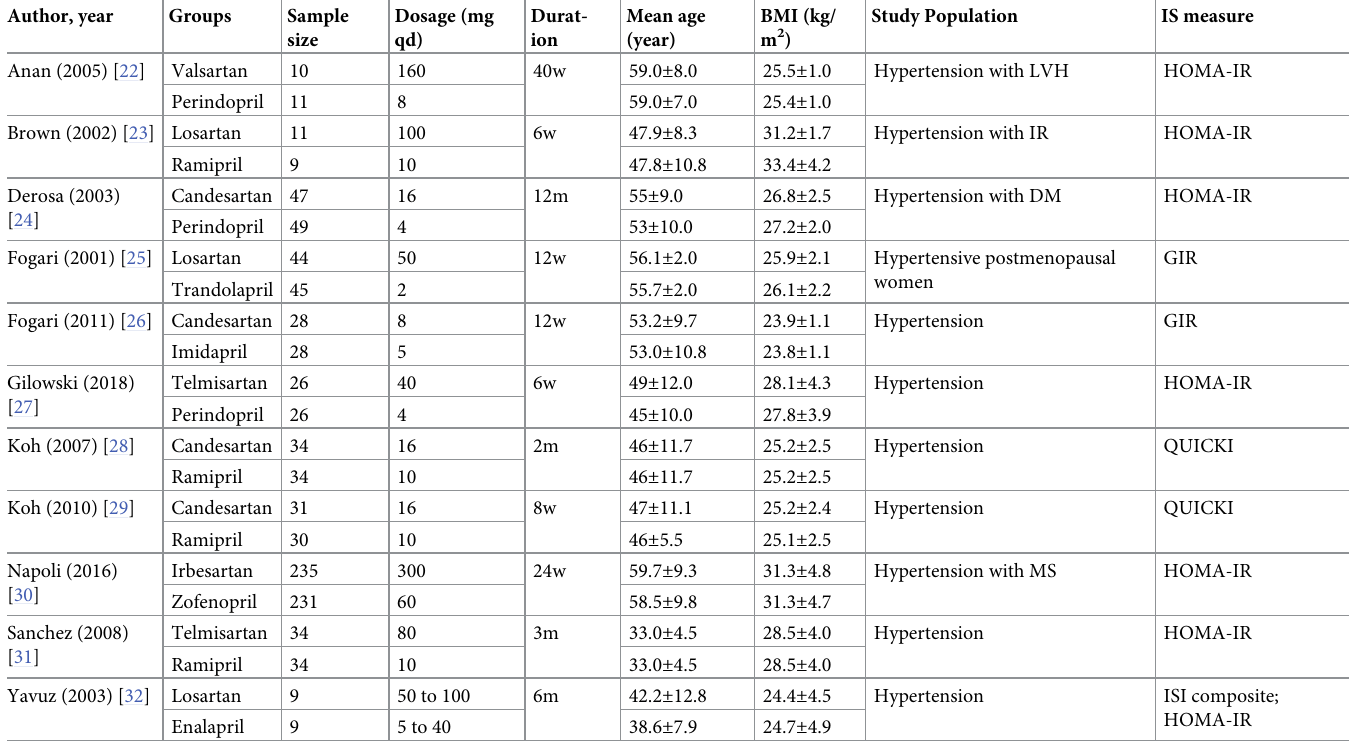
Table 1. Baseline characteristics of trials included in the